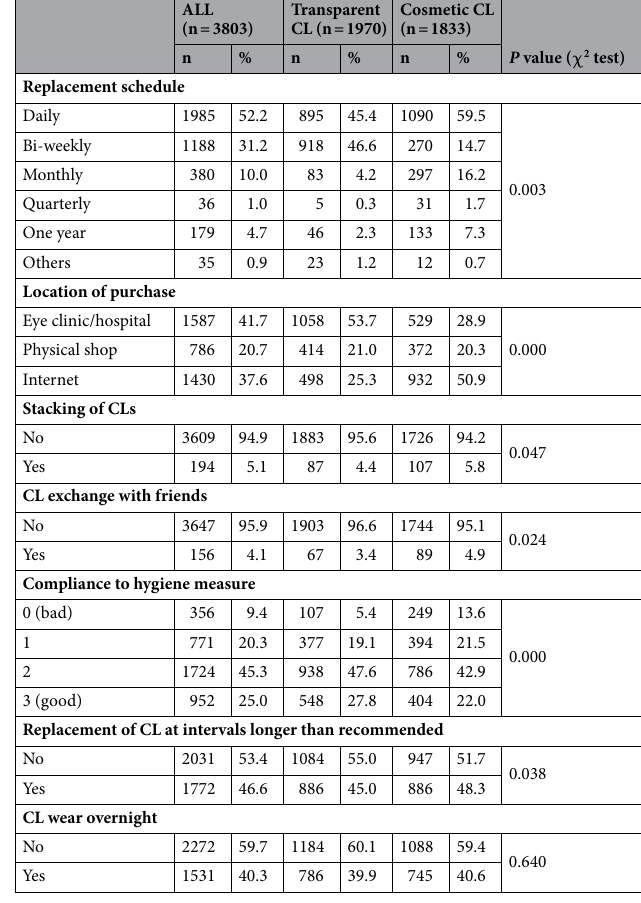
Table 2. Characteristic of studied population by lens type (categorical variables). CL, contact